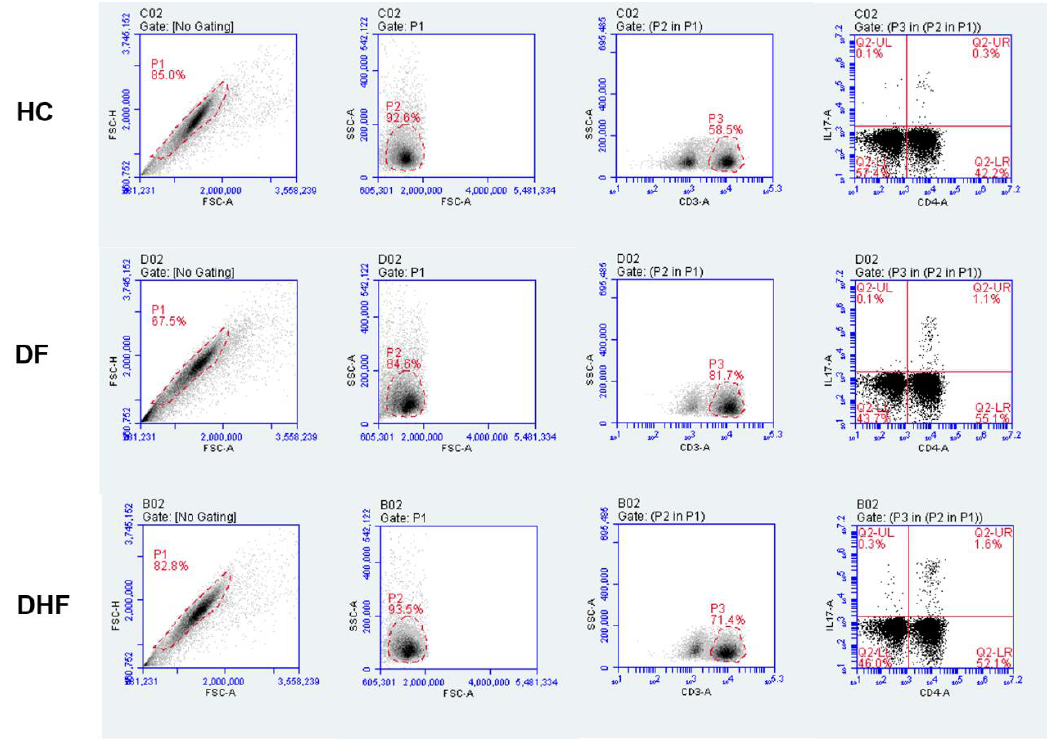
Figure 5. Strategy for IL-17-producing cell analysis. Dot plots are representative of one HC, DF and DHF patient. Ten thousand events were acquired from lymphocyte regions based on CD3-FITC staining. Percentages of IL-17-producing cells were identified in the CD4+ and CD4- region with the quadrants established based on isotype controls. CD3+ CD4+ IL-17+ cells were considered to be Th17 cells mainly.